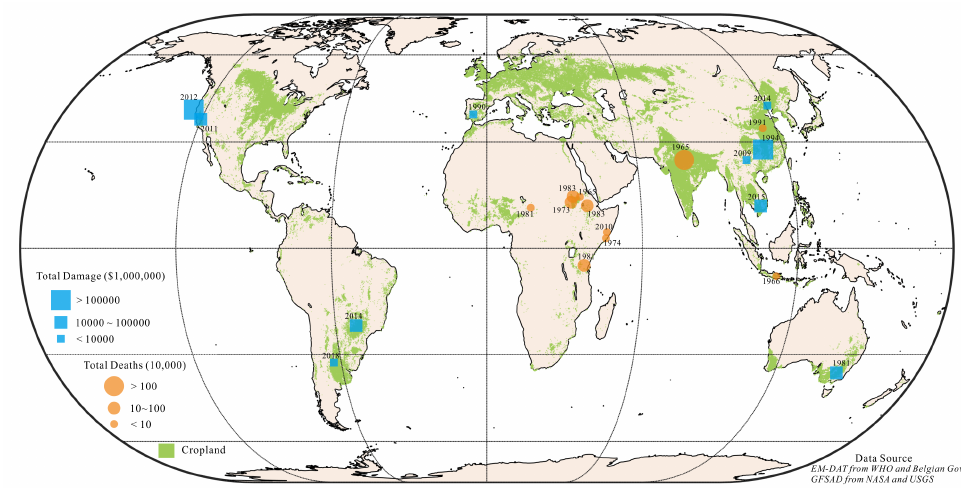
Figure 1. Distribution of major drought events since